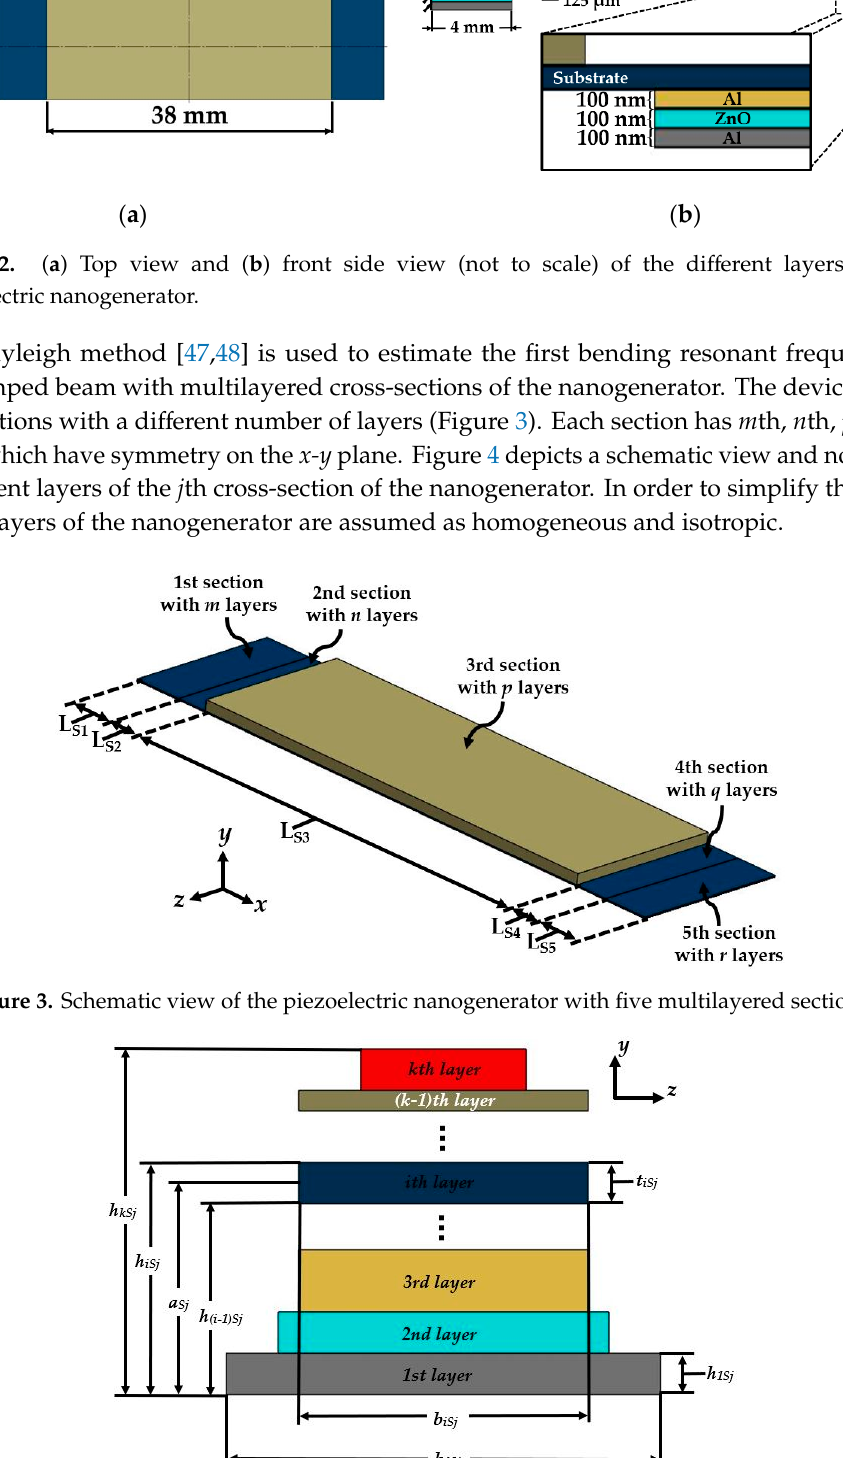
Figure 1. Isometric view of a piezoelectric nanogenerator located at the bottom side of an electronic display at a smart office desk.